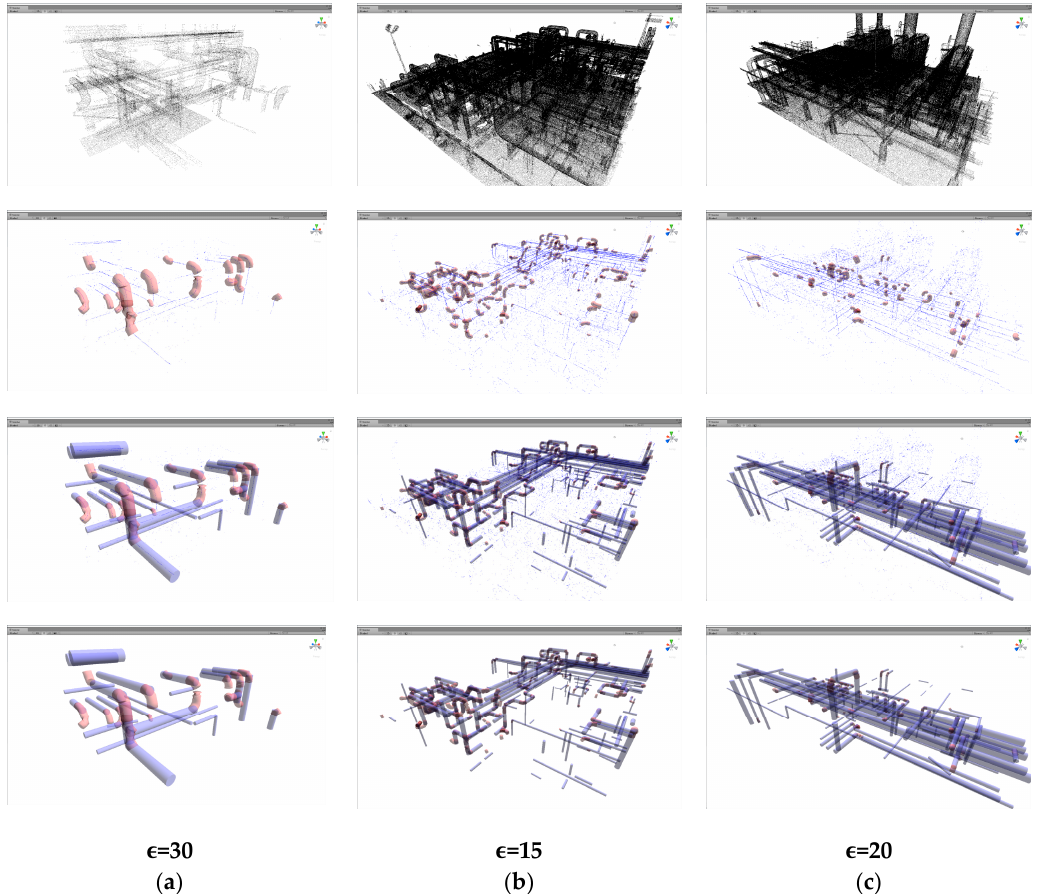
Figure 12. Estimation from nonsegmented data with 𝛜 . From top: point cloud/bent area, center axis/bent area, center axis, straight/final result mapping: ( a ) simple data; ( b ) complicated data 1; ( c ) complicated data 2. Table 1. Results in Figure 12 (unit: